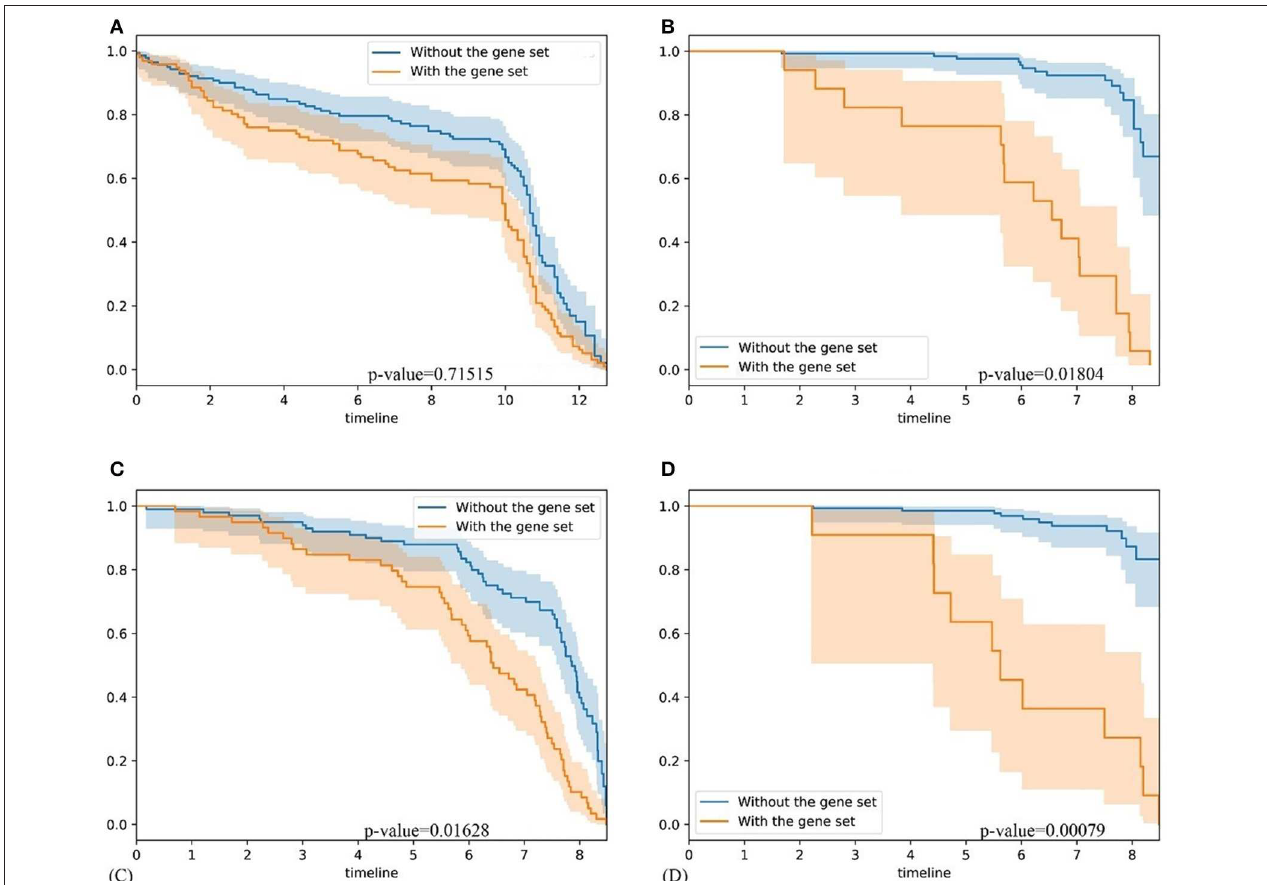
FIGURE 6 | Comparison of gene set based patient survival group classification. “With gene set” means patients with over 80% expression of genes in the gene set significantly changed. “Without the gene set” means patients with the expression of genes in gene set are normal. (A) The survival curve of core gene set identified by the GSAS algorithm applied on the GSE1456 dataset. (B) The survival curve of the top-ranked gene set identified by our method applied on the GSE1456 dataset. (C) The survival curve of core gene set identified by the GSAS algorithm applied on the GSE3494 dataset. (D) The survival curve of the top-ranked gene set identified by our method applied on the GSE3494